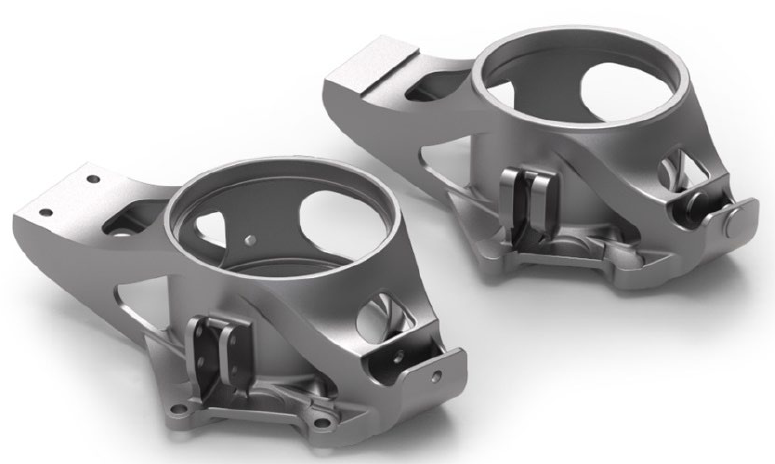
Figure 4. The final 3D data of the workpiece ( left ) and casting ( right ).